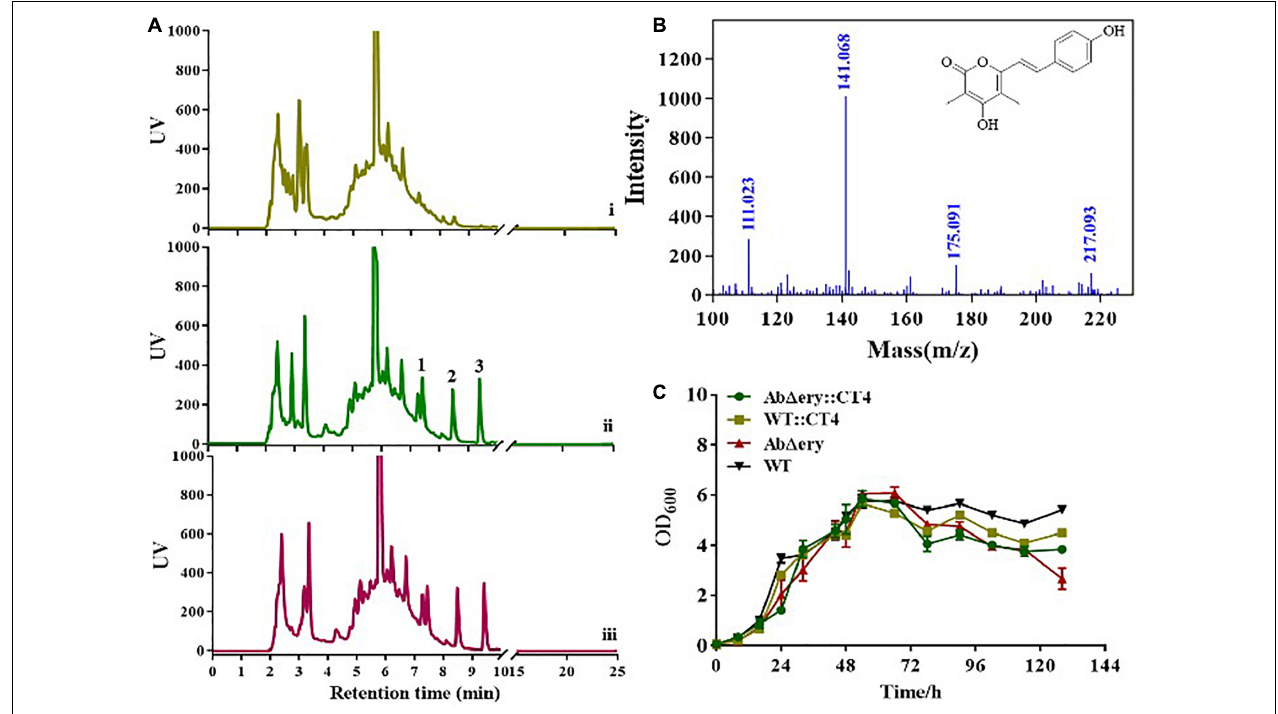
FIGURE 6 | HPLC and LC-MS determination of heterologous gene expression products. (A) HPLC spectra of Ab (cid:49) ery (i) , WT:CT4 (ii) , and Ab (cid:49) ery :CT4 (iii) . Compared with control, three new peaks appeared after introduction of the heterologous genes, 1 is intermediate product 4-coumaric acid, 2 is the target product, and 3 is the by-product cinnamic acid (b) LC-ESIMS spectrum of 2 and the molecular ion peak [M + H] + is m/z 259.0956. (C) Growth curve for the Ab (cid:49) ery (control), WT (control), Ab (cid:49) ery :CT4, and WT:CT4.